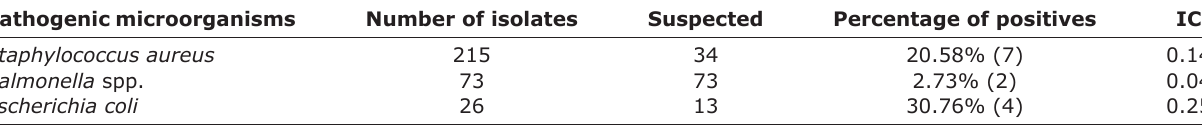
Table-7: Percentage of positive for pathogenic microorganisms. Pathogenic microorganisms